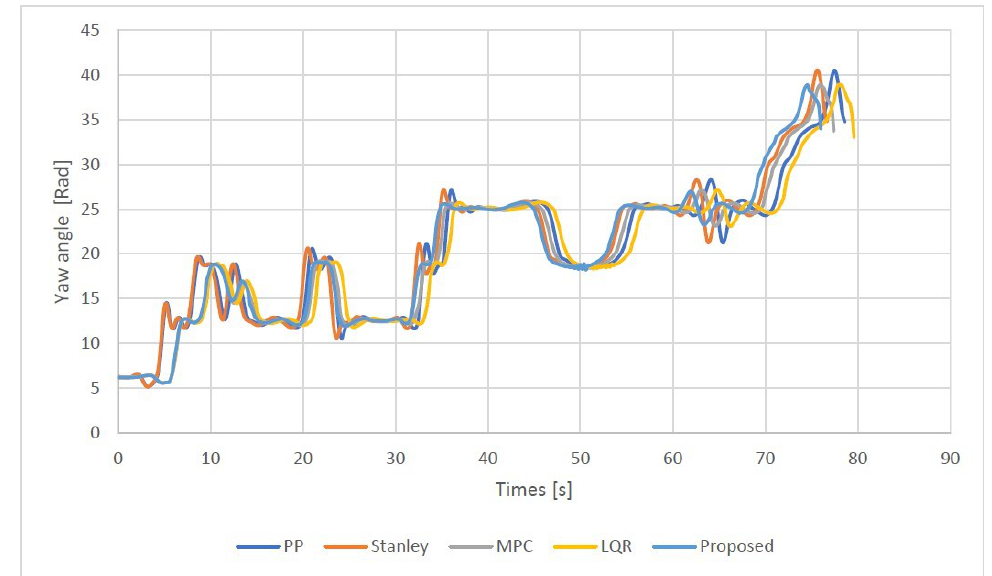
Figure 15. Yaw angle presentation of different trajectory tracking